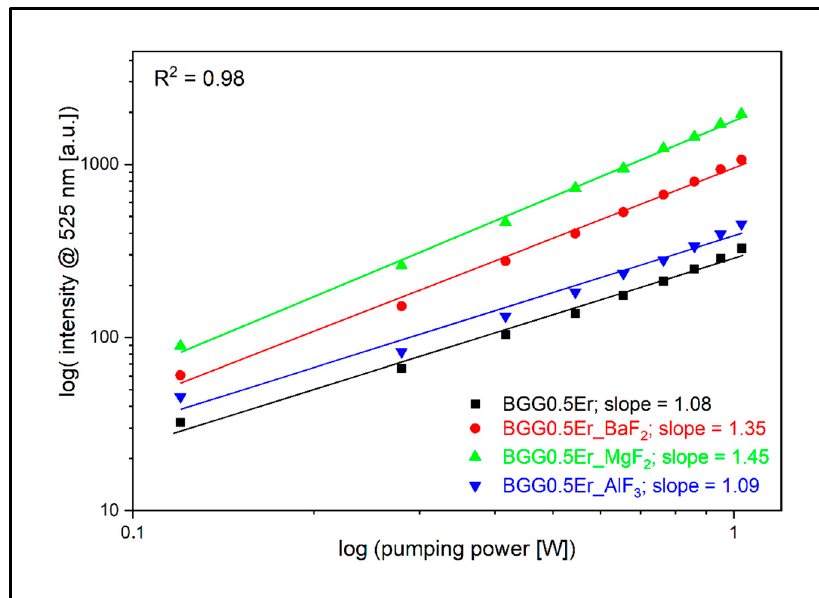
Figure 18. Log–log plot of up-conversion emission at 525 nm of fabricated